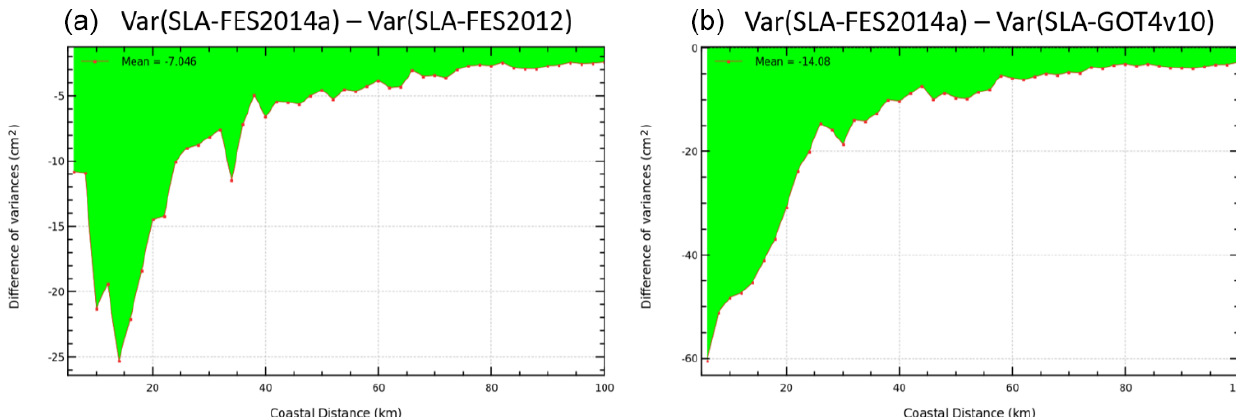
Figure 17. Difference of variance of SLA for the AltiKa (AL) mission as a function of distance to the coast, when using the new FES2014a tide model instead of the FES2012 solution (a) or instead of the GOT4v10 solution (b) in the SSH calculation (cm 2 ). The accuracy im- provement between the FES2012 and FES2014 prior solutions is a key ingredient in the accuracy improvement between the FES2012 and FES2014a assimilated solutions. AL cycles 1–14 are used. Tidal corrections made for both models with their native constituents’ spectrum (i.e. not restricted to their common constituents). When necessary, atlas solutions were extended toward the coast (low-order